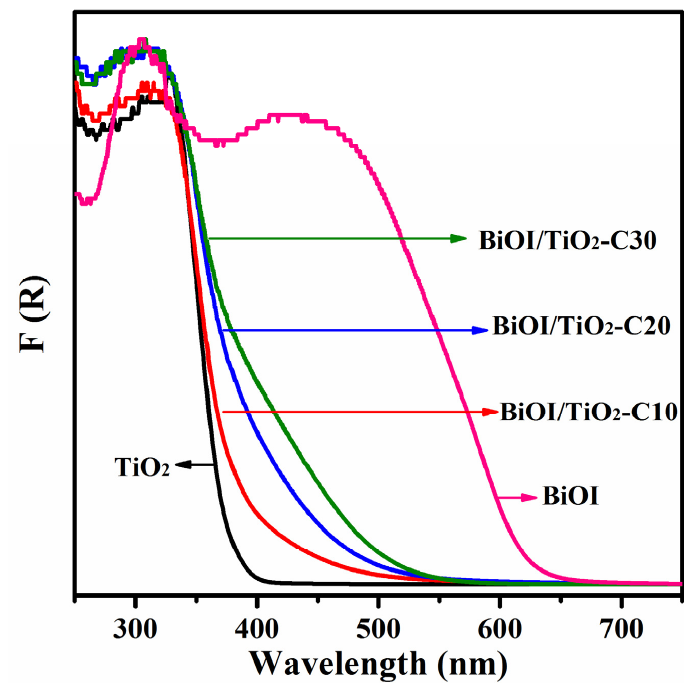
Figure 6. UV ‐ vis absorption spectra of different samples. Figure 6. UV-vis absorption spectra of different